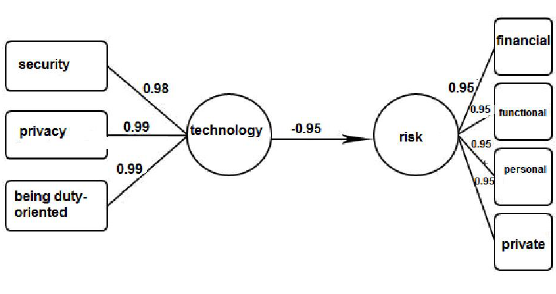
Fig. 3. The results of testing the first